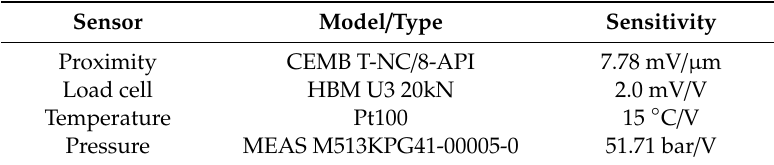
Figure 8. Photo of loaded pads with installed temperature probes. Table 5. Model and sensitivity of the sensors.